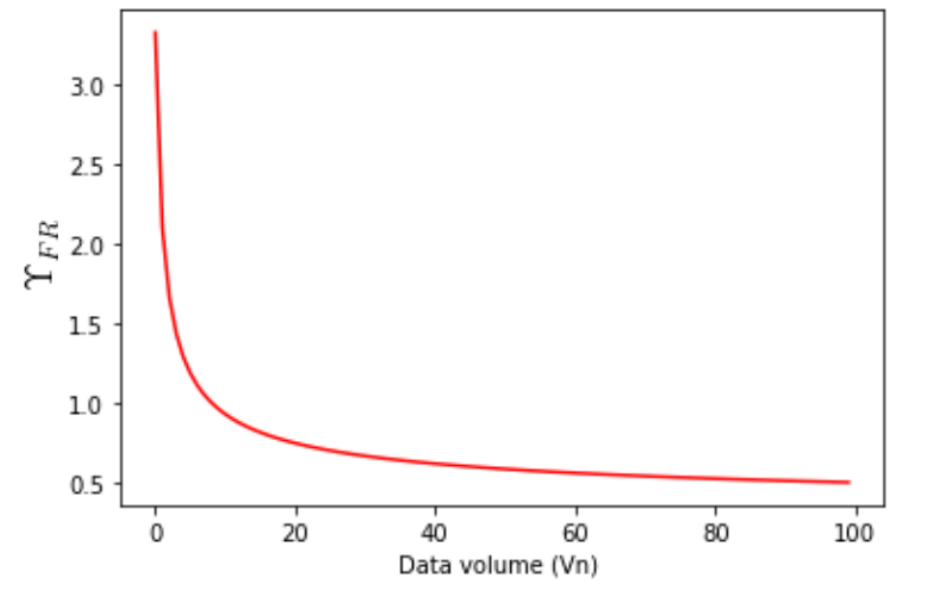
Figure 1. Dependence of irrelevance score component Υ FR on data volume ( V n